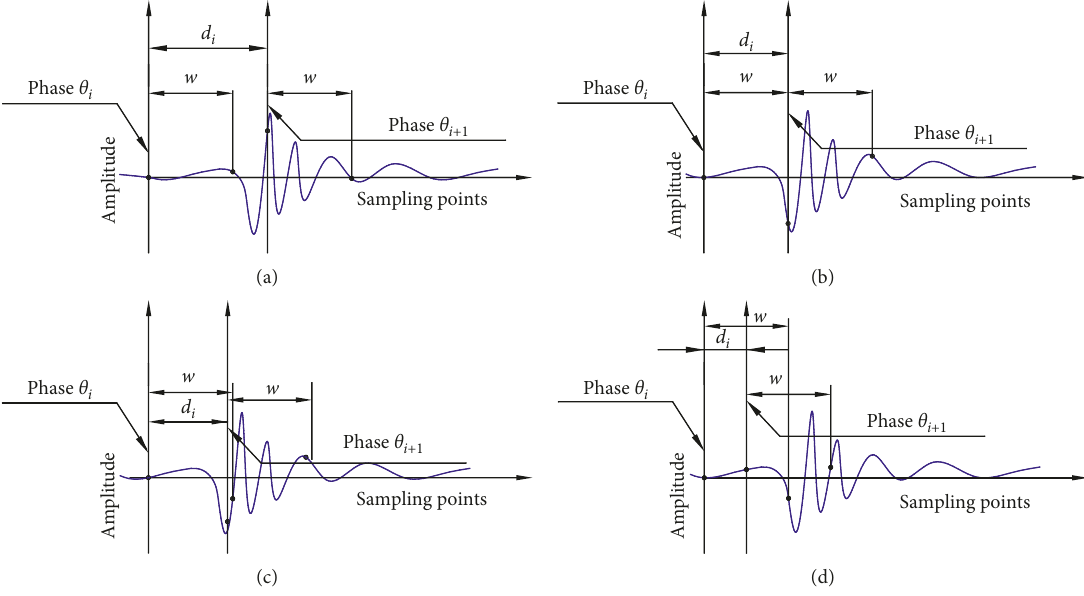
Figure 7: Influence of the relationship between w and d then the main energy area of the fault components will be destroyed or skipped, as shown in Figures 7(a) and 7(b). If w /2 ≤ d i < w , then the main energy area is also destroyed, as shown in Figure 7(c). If d i < w /2, then the main energy area is hardly